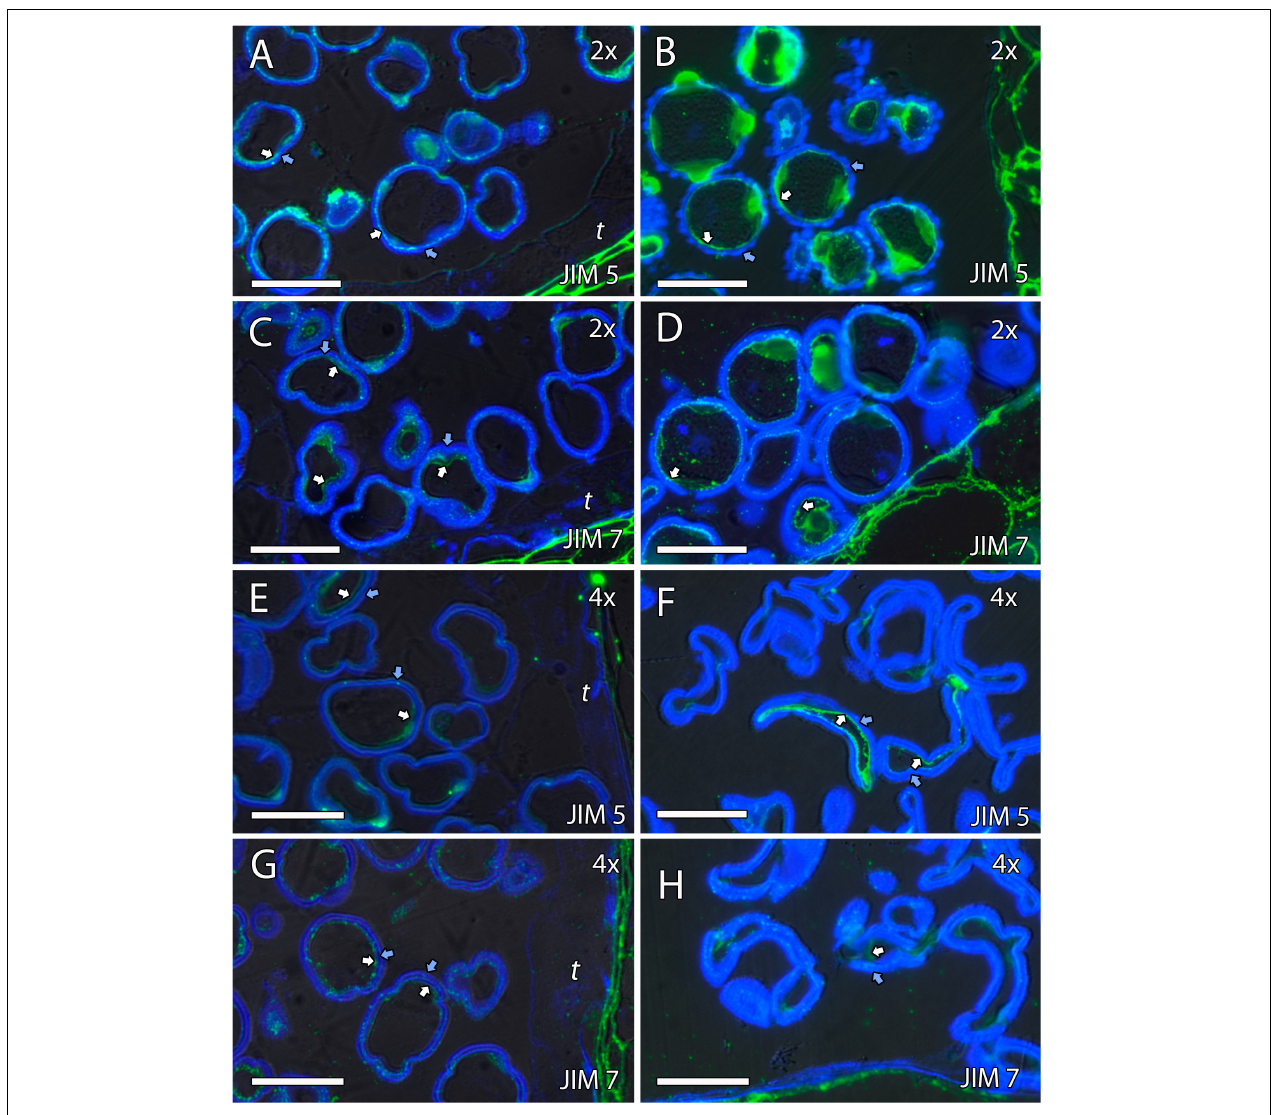
FIGURE 6 | Immunolocalization of pectins during microgametogenesis in diploid and doubled diploid “Clemenules” clementine. Monoclonal antibodies used: (A,B,E,F) JIM5 against unesterified pectins and (C,D,G,H) JIM7 against methyl-esterified pectins. (A,C,E,G) JIM5- and JIM7-specific labeling (white arrows) was weakly observed in the intine of the microspore wall and in the aperture sites in the vacuolated stage in (A,C) diploid and (E,G) doubled diploid “Clemenules”. Unesterified (JIM5) (B) and methyl-esterified (JIM7) (D) pectins (white arrows) were observed in the intine and aperture sites of pollen grains at anthesis in diploid “Clemenules” clementine. Pollen grains of doubled diploid “Clemenules” shrank at anthesis, showing unesterified (JIM5) (F) and methyl-esterified (JIM7) (H) pectins (white arrows) in the intine. The exine was observed in blue due to autofluorescence, and it is indicated with blue arrows. All scale bars = 25 mm. Tapetum (t), diploid (2x), and doubled diploid